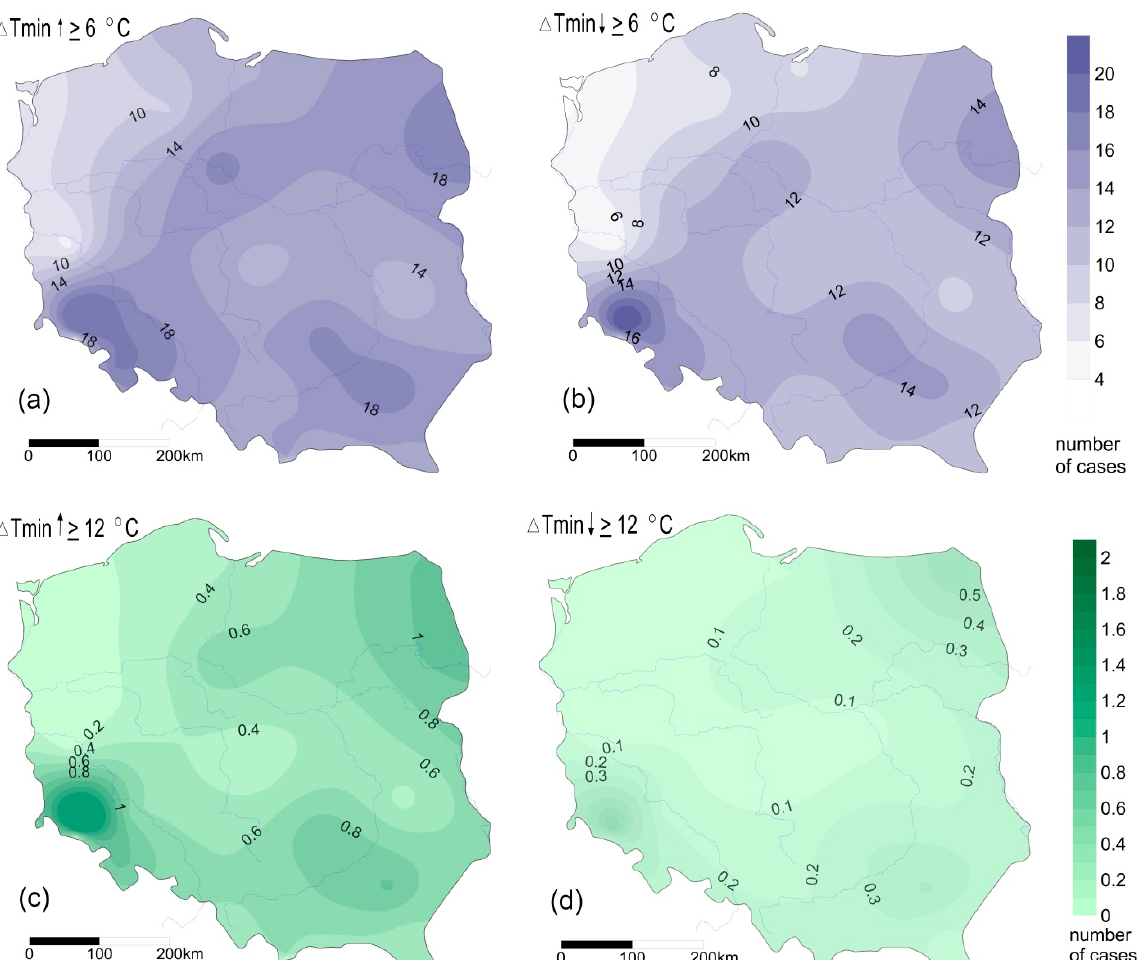
Figure 7. Spatial distribution of annual averages of large interdiurnal increases ( a ) and decreases ( b ) and very large increases ( c ) and very large decreases ( d ) in Tmin in Poland in the years 1966–2015.